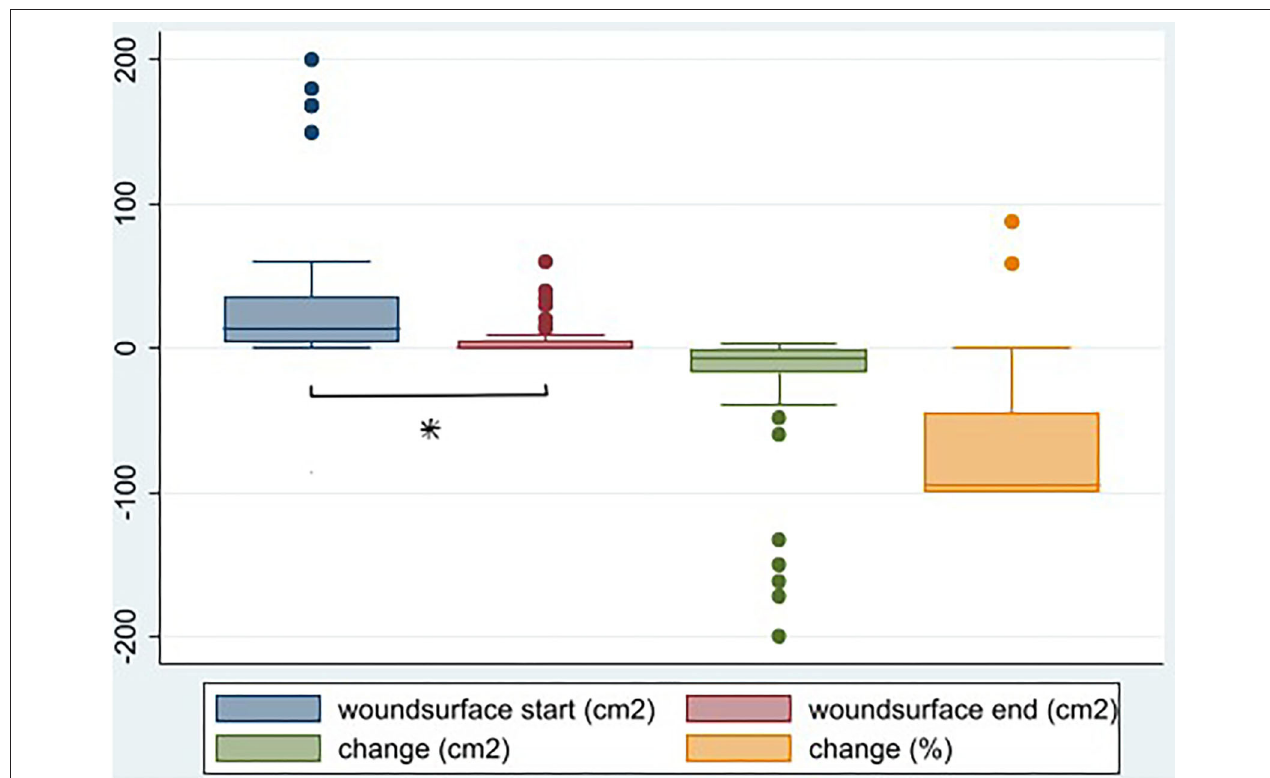
FIGURE 1 | Wound surface before and after HBOT (cm 2 ), change in wound surface (surface after—surface before in cm 2 ) ( p < 0.001), and as percentage of surface before (%), N = 59. *Denotes statistical significance.